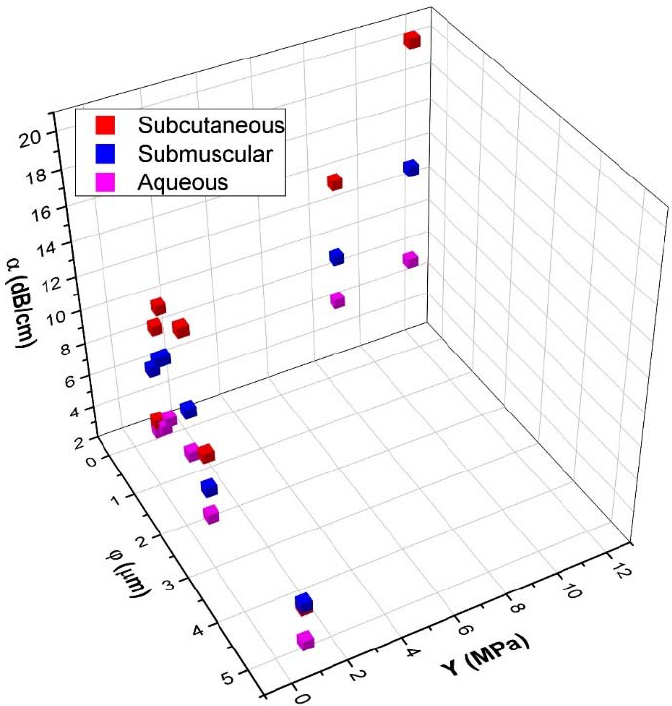
Figure 8. Comparison of attenuation coefficient ( α ) at 8.5 MHz, Young’s modulus (Y) and pore ‐ diameter ( φ ) for SC, SM, and Aq implants.